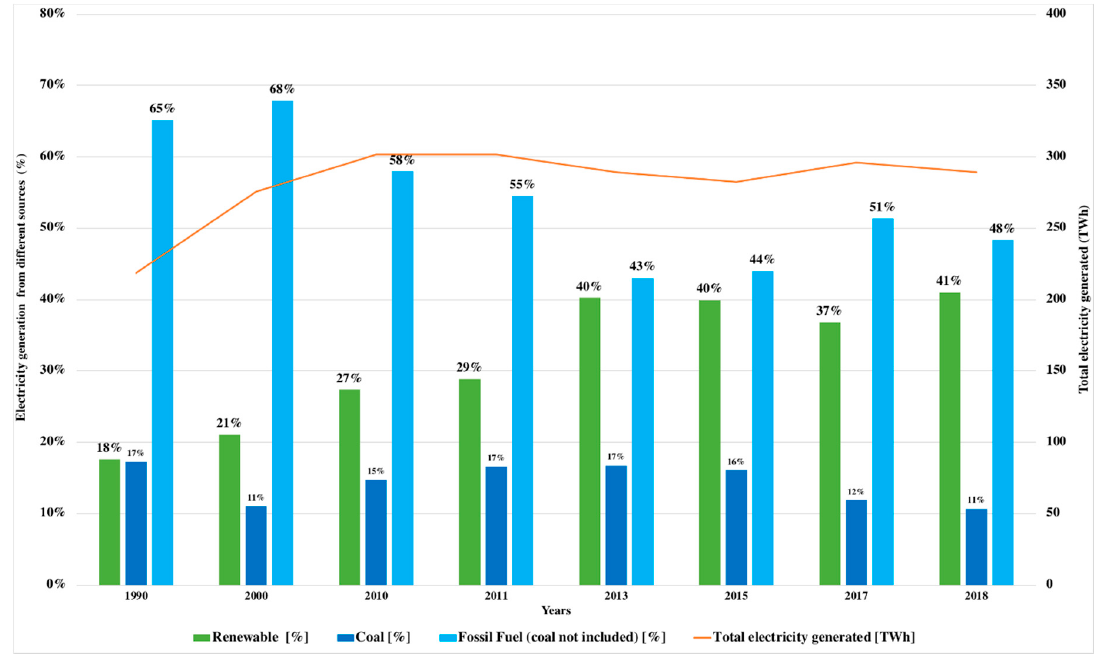
Figure 1. Evolution of Italy’s energy mix [14].